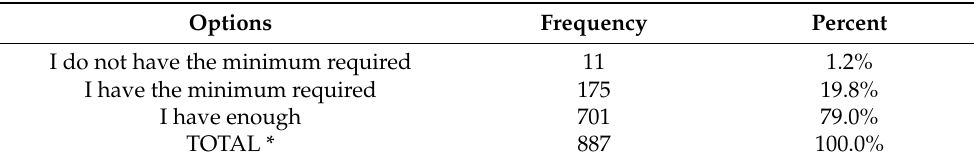
Table 2. In terms of housing situation (e.g., parents, children, sibling, spouse, friends in the same house; living alone at home, etc.), do you feel you have the necessary conditions to carry out your distance learning activity? Options Frequency Percent